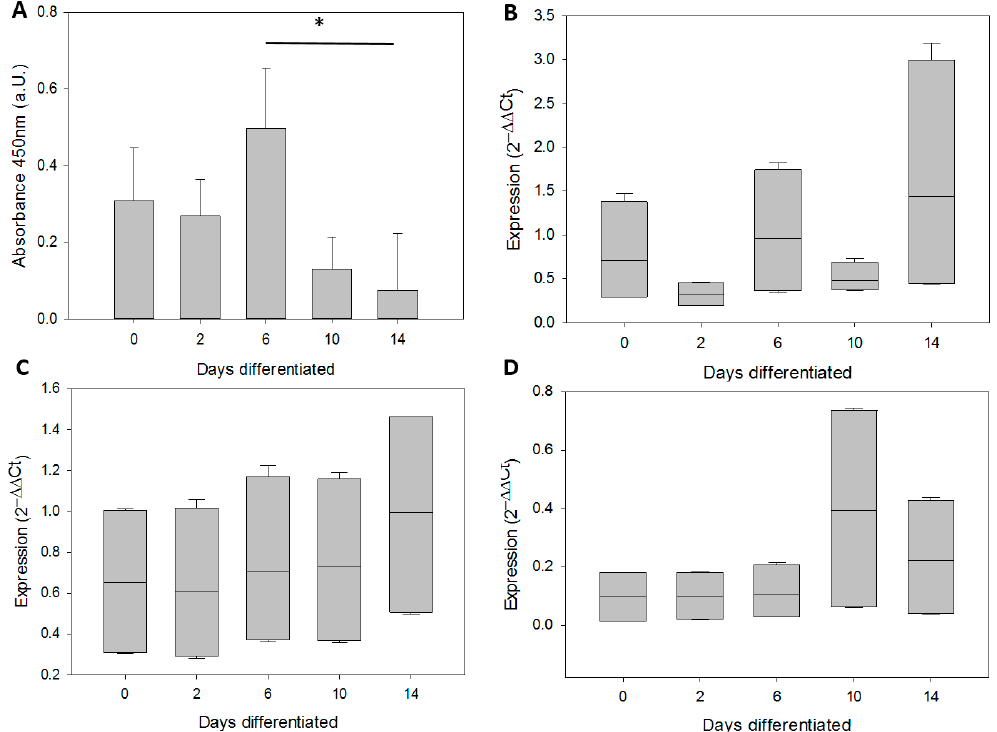
Figure 4. Telomerase activity and expression of telomerase-related genes in neural precursor stem cells and their differentiated progeny. ( A ) Telomerase activity, mean and SD from 2 independent differentiation experiments with significant differences between day 6 and 14; ( B ) α -spliced hTERT; ( C ) WT hTERT; ( D ) h TR expression. ( B – D ) have been normalised to SH-SY5Y, where 2 −ΔΔ Ct was set to 1. * p < 0.05. One way ANOVA (on ranks for ( B – D )) and Holm-Sidak post hoc test was performed was performed on these data. The bars show mean and SD of n = 2 (independent qPCR runs) for all groups in ( B – D ). Genes 2016 , 7 , 27